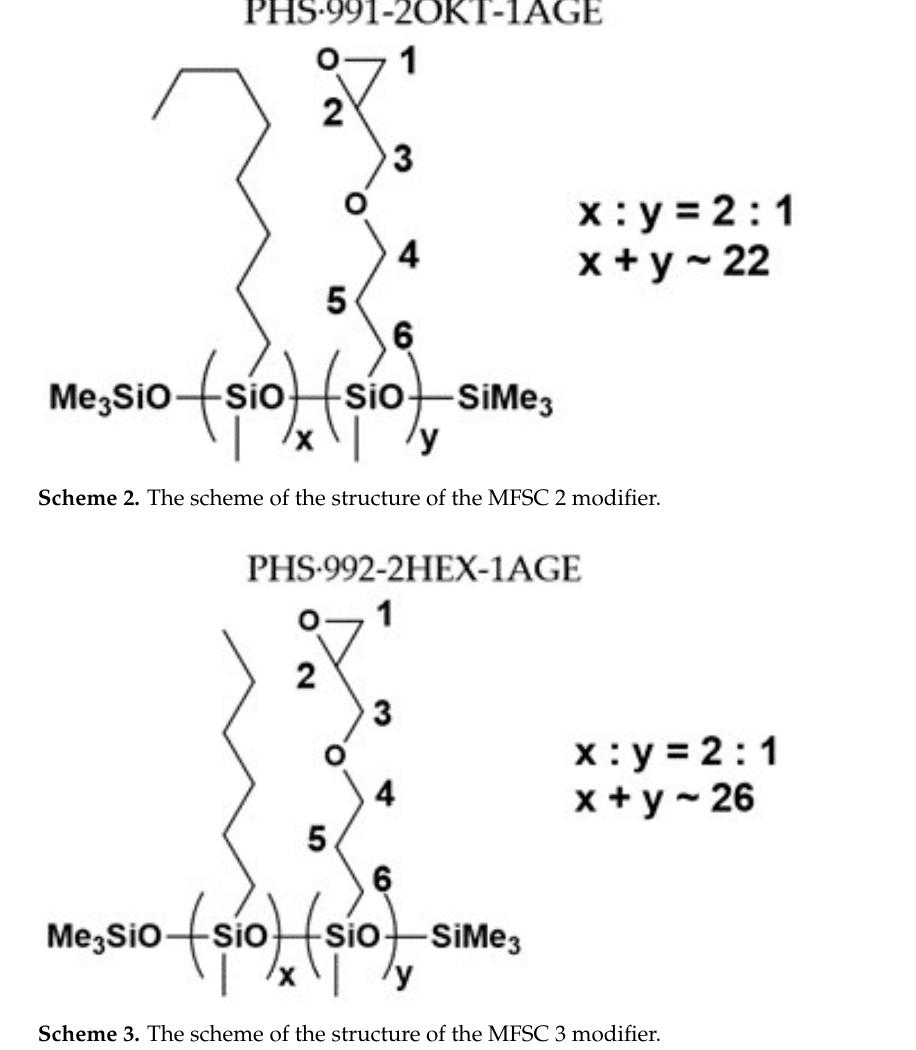
Scheme 2. The scheme of the structure of the MFSC 2 modifier.